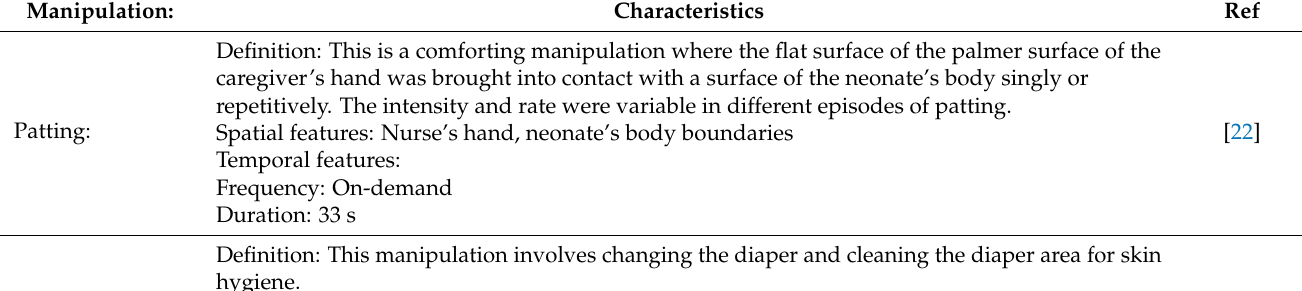
Table 1. Visual features of manipulations.